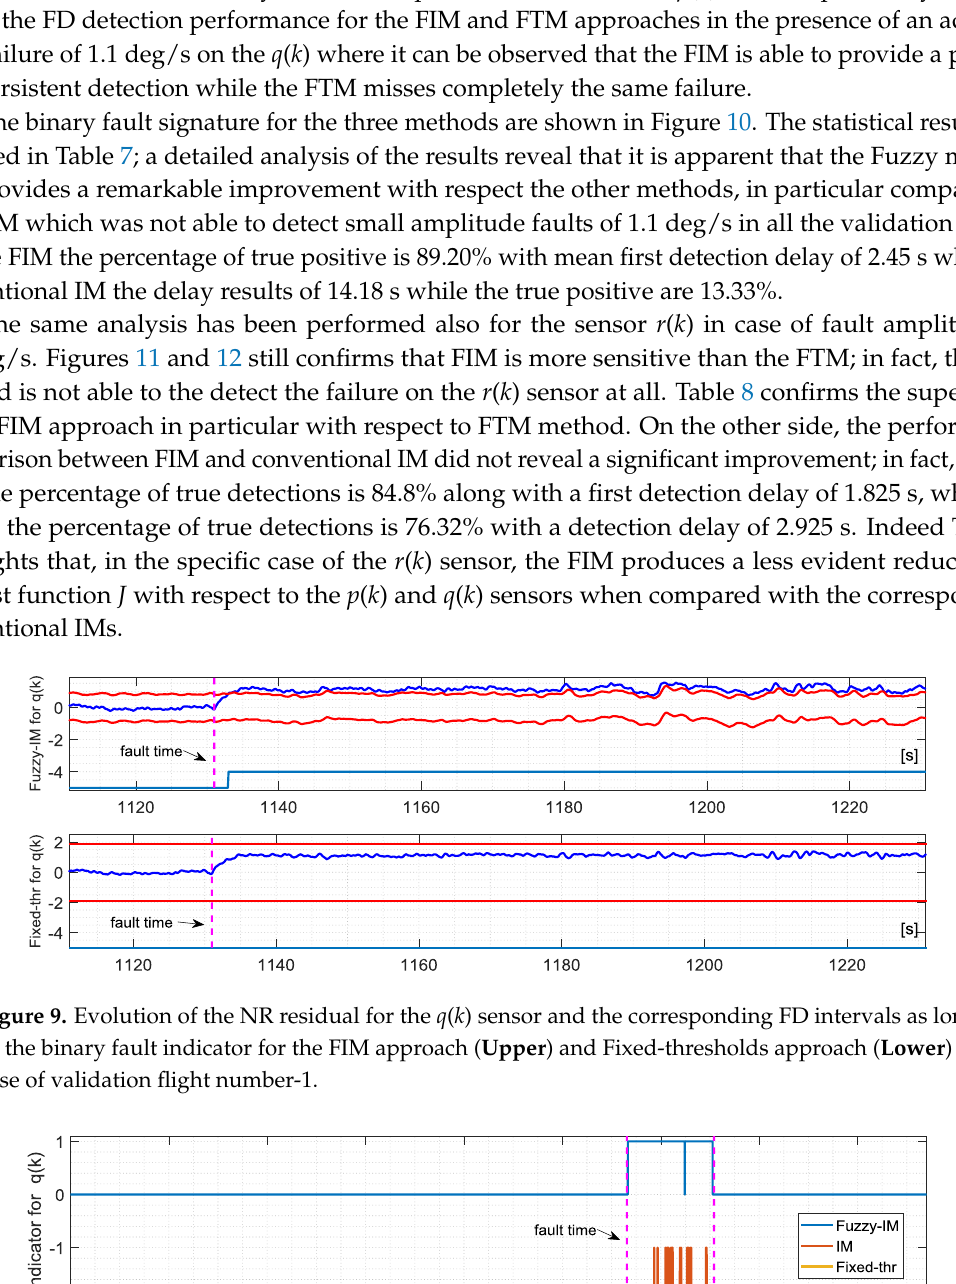
Figure 10. Evolution of the FIM, IM and FTM BINARY FAULT indicators for validation flight-1 in case of hard failure on the q ( k ) sensor of amplitude 1.15 deg/s active in a time window of about 3 min indicated by the vertical dashed lines. Table 7. Mean FD performance in the four validation flights for the sensor q (k).